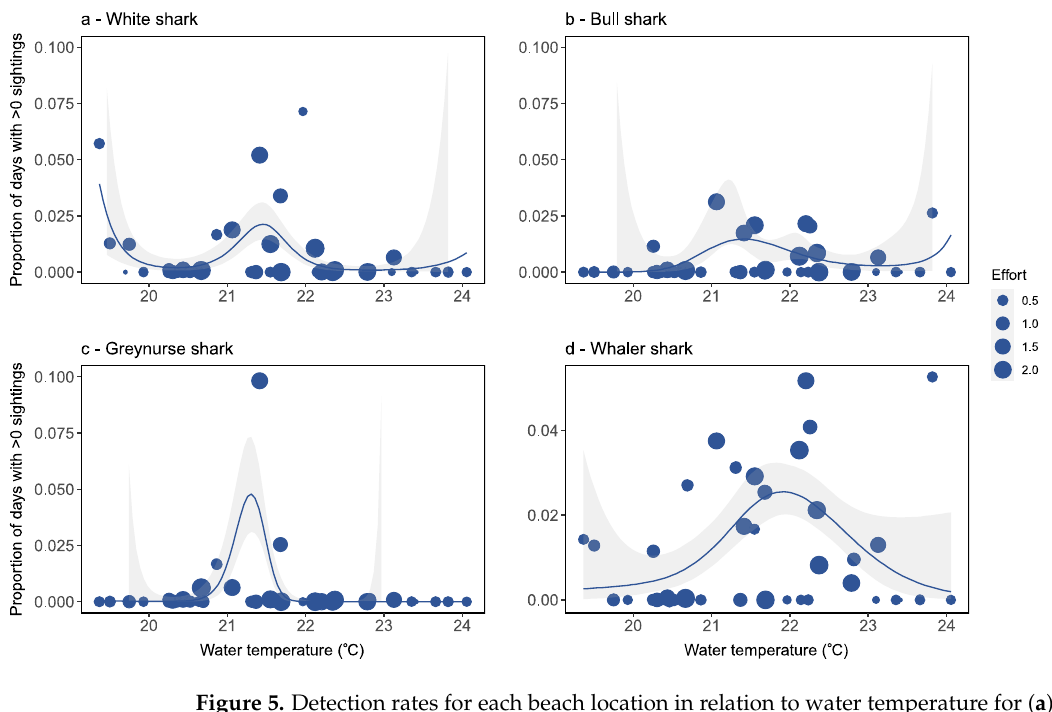
Figure 5. Detection rates for each beach location in relation to water temperature for ( a ) white shark, ( b ) bull shark, ( c ) greynurse shark, and ( d ) whaler shark species, and estimated response curves with a 95% confidence region. Points are sized proportionally to the total flight effort at each location proportional to the average effort. Thus, a weight of 1.0 equals average flight effort, <1 equals below average effort, and >1 equals above average effort.